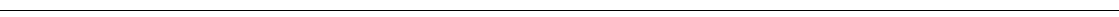
Fig. 4 The spindle poles act as brakes during meiotic chromosome segregation. a Schematics and still images from live imaging of control not ablated (top), control ablated (second from top), central spindle (second from bottom) and spindle pole (bottom) laser-mediated ablation in GFP-tagged α -tubulin and mCherry-tagged histone H2B expressing fertilized oocytes. White arrowheads indicate the ablation events. Scale bar, 2 µ m. b Distance between the centroid of each set of segregating chromosomes over time after anaphase onset in the indicated conditions. Error bars represent the SEM. Thick and thin vertical dashed lines represent the average and minimum/maximum times of ablation respectively. Background colors represent average duration of anaphase A (light orange) and B (light blue) respectively. (One-way ANOVA: control ablation at 180 s, p = 0.9297; central spindle at 180 s, p = 0.9007; Spindle pole at 180 s, p = 0.9924; control ablation at 300 s, p = 0.9951; central spindle at 300 s, p = 0.0045; spindle pole at 300 s, p = 0.1771) c Still images from live imaging of fertilized oocytes expressing GFP-tagged α -tubulin and mCherry-tagged histone H2B in the indicated conditions. Timings from anaphase onset are indicated at the bottom of each frame. Scale bar, 5 µ m. d Distance between the centroid of each set of segregating chromosomes over time after anaphase onset in the indicated conditions. Tracking was performed until the anaphase spindle broke apart at the end of polar body extrusion. Error bars represent the SEM. Background colors represent average duration of anaphase A (light orange) and B (light blue) respectively. (One-way ANOVA: aspm-1 Asp (RNAi) at 180 s, p = 0.2281; aspm-1 Asp + lin-5 NuMA (RNAi) at 180 s, p = 0.0910; aspm-1 Asp + dhc-1 dynein (RNAi) at 180 s, p = 0.6103; aspm- 1 Asp (RNAi) at 240 s, p = 0.0018; aspm-1 Asp + lin-5 NuMA (RNAi) at 240 s, p = 0.0015; aspm-1 Asp + dhc-1 dynein (RNAi) at 240 s, p = 0.0077) e Still images from live imaging of fertilized oocytes expressing GFP-tagged β -tubulin and mCherry-tagged histone H2B in the indicated conditions. Timings from anaphase onset are indicated at the bottom of each frame. Scale bar, 5 µ m. f Distance between the centroid of each set of segregating chromosomes over time after anaphase onset in the indicated conditions. Tracking was performed until the anaphase spindle broke apart at the end of polar body extrusion. Error bars represent the SEM. Background colors represent average duration of anaphase A (light orange) and B (light blue) respectively. (One-way ANOVA: dhc-1 (or195ts) , 16 °C at 180 s, p = 0.0926; dhc-1(or195ts) , 26 °C at 180 s, p = 0.9999; aspm-1 Asp + lin-5 NuMA (RNAi) + dhc-1(or195ts) , 26 °C at 180 s, p = 0.4751; dhc-1(or195ts) , 16 °C at 240 s, p = 0.0009; dhc-1(or195ts) , 26 °C at 240 s, p = 0.9853; aspm-1 Asp + lin-5 NuMA (RNAi) + dhc-1(or195ts) , 26 °C at 240 s